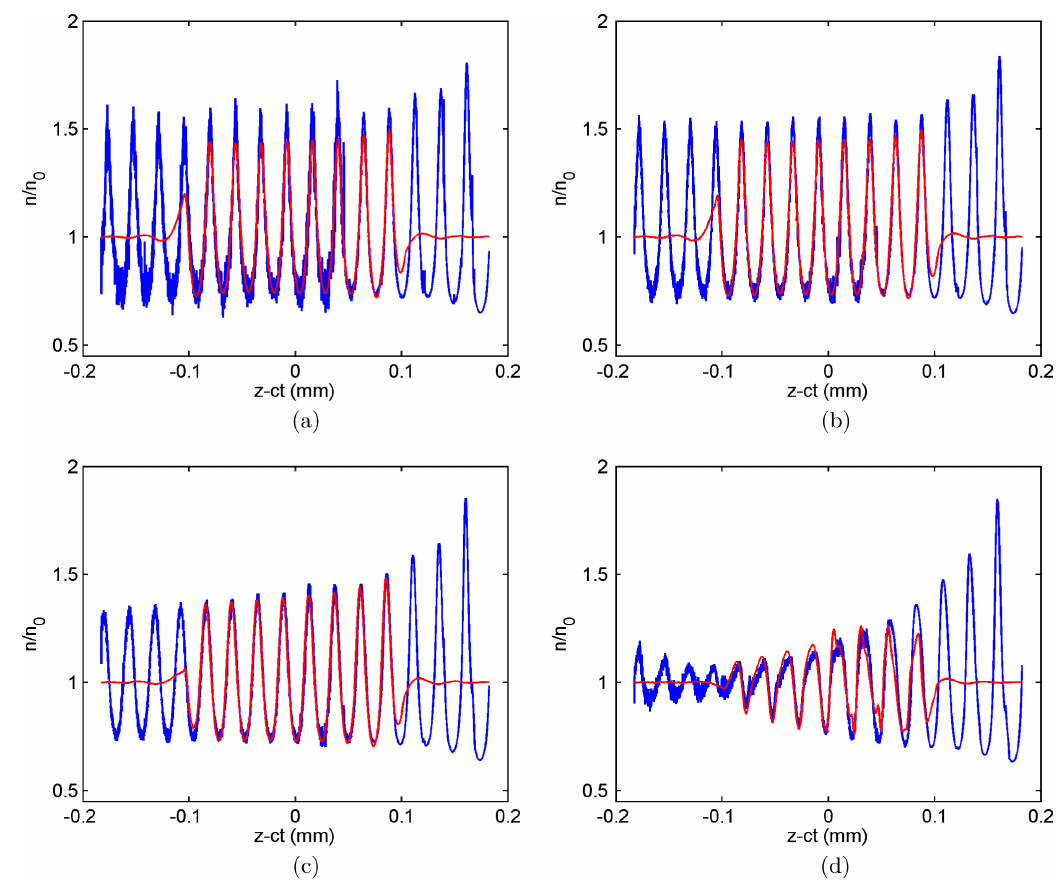
FIG. 5. Comparison of measured longitudinal electric field (red line) and the actual longitudinal electric field averaged over the distance (blue line) when the laser has propagated (a) 0.8 mm, (b) 1.9 mm, (c) 3.8 mm, and (d) 6.3 mm. The measurement only takes place from about − 0 . 1 mm to 0.1 mm relative to the center of the